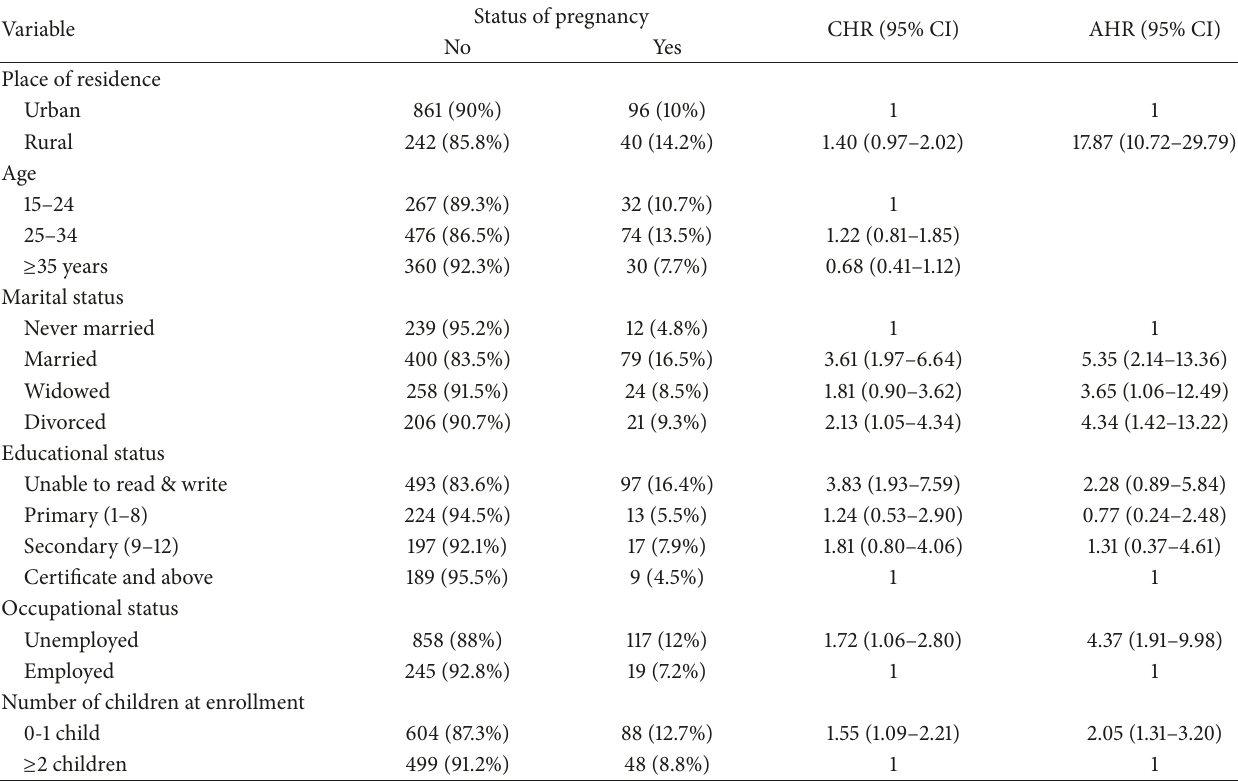
Table 3: Cox’s proportional hazards models examining predictors of incidence of pregnancy with 95% CIs, among women on ART in Debre Markos Referral Hospital, Northwest Ethiopia, Sept. 2011 to Aug. 2015 ( 𝑁 =